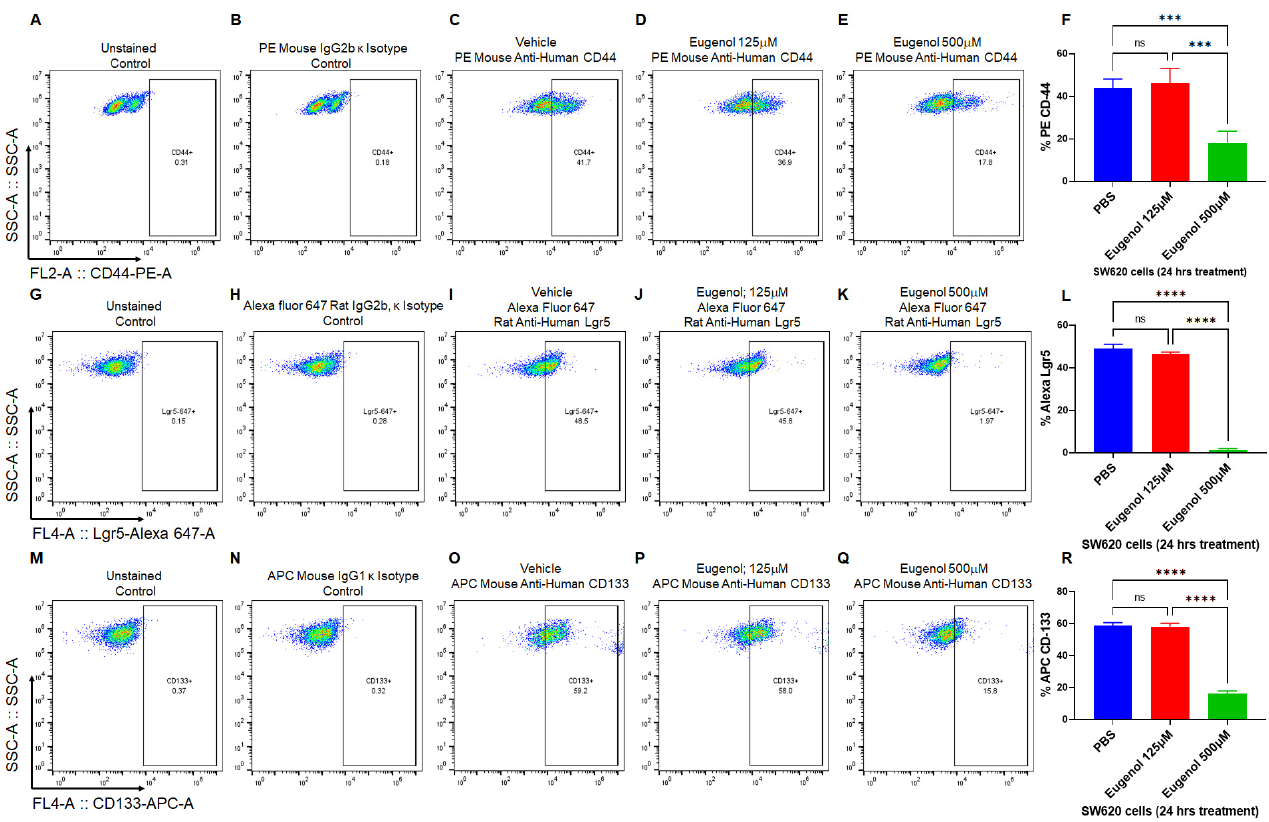
Figure 5. EUG decreases cancer stem cell populations in human colon cancer cells. CSCs positive for Lgr5, CD44, and CD133 cell populations are associated with poor prognosis and drug resistance in CRC tumors. HCT-116 colon cancer cells were treated with DMSO or EUG (125 and 500 µM). After 24 h, cells were subjected to flow cytometry analysis using three CSC markers (CD44, Lgr5, and CD133). Cells treated with 500 µM EUG showed a significant reduction in CD44 + ( A – F ), LGR5 + ( G – L ), and CD133 + ( M – R ) (N = 4, *** p < 0.001, **** p < 0.0001, mean ± SD). Unstained cells and Mouse IgG2b or IgG1 Isotype controls (panels ( B , H , N )) were used to confirm the accuracy of measurements with antibodies. ns—non